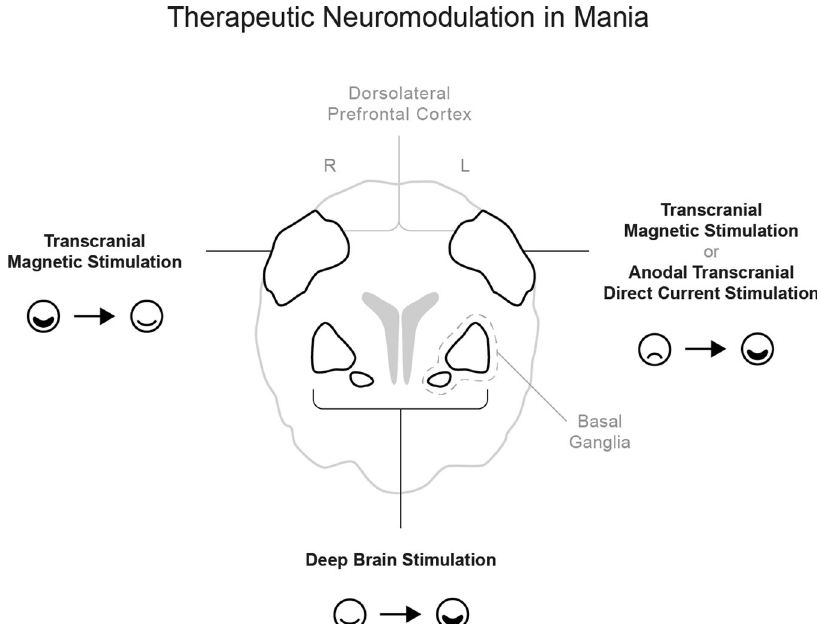
Fig. 3 Therapeutic neuromodulation in mania. The functional circuit of mania may help de fi ne potential therapeutic neuromodulation targets to treat or avoid